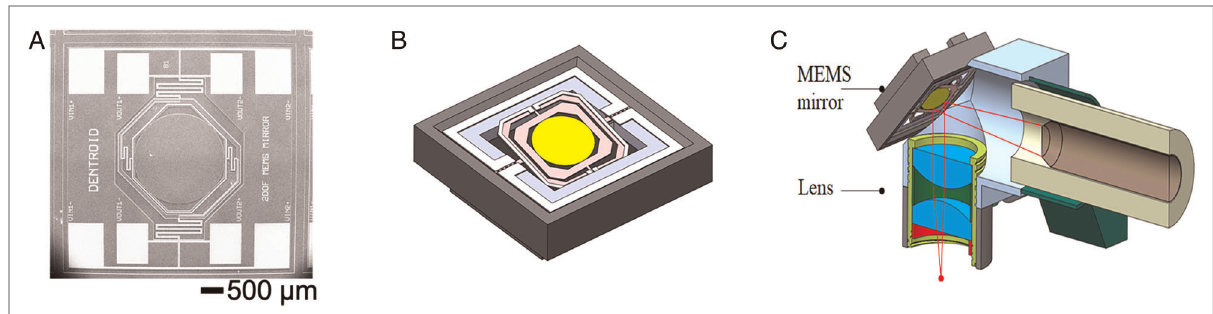
FIGURE 2 ( A ) Scanning electron microscopy image of a 2DOF MEMS mirror with ( B ) its schematic representation, and ( C ) the intraoral head of the device with MEMS mirror position